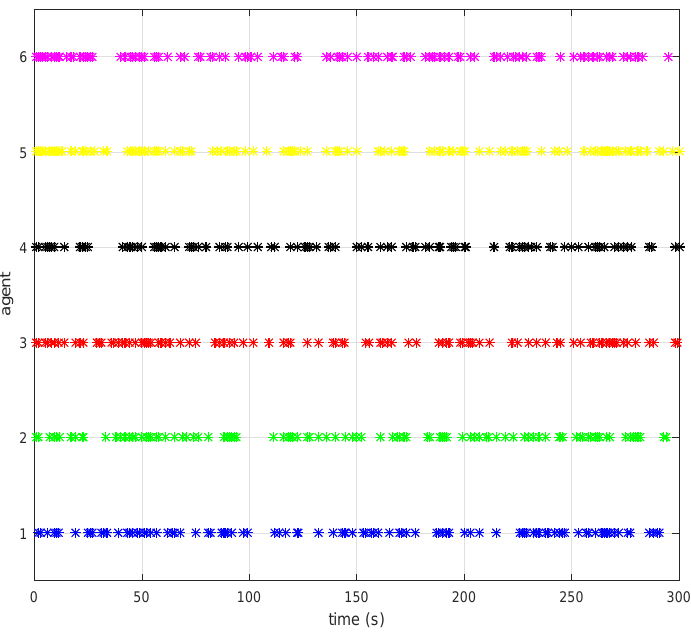
Figure 6. The triggering